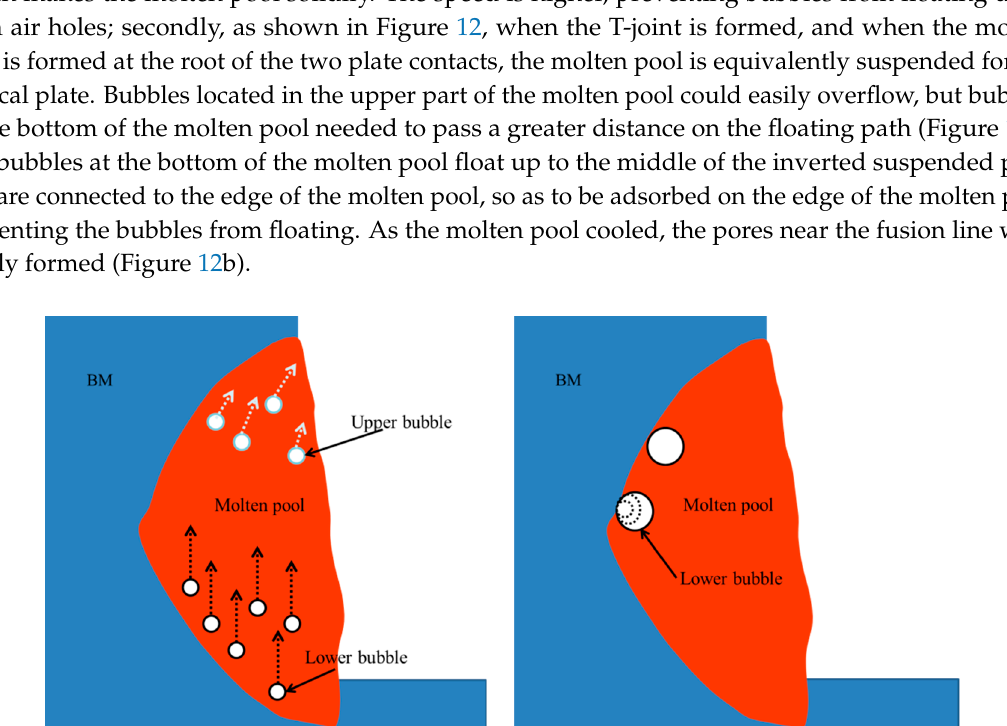
Figure 12. Pore-forming mechanism at lack of penetration. ( a ) Bubbles floating up in the bath; and, ( b ) bubbles forming pores near the weld line.